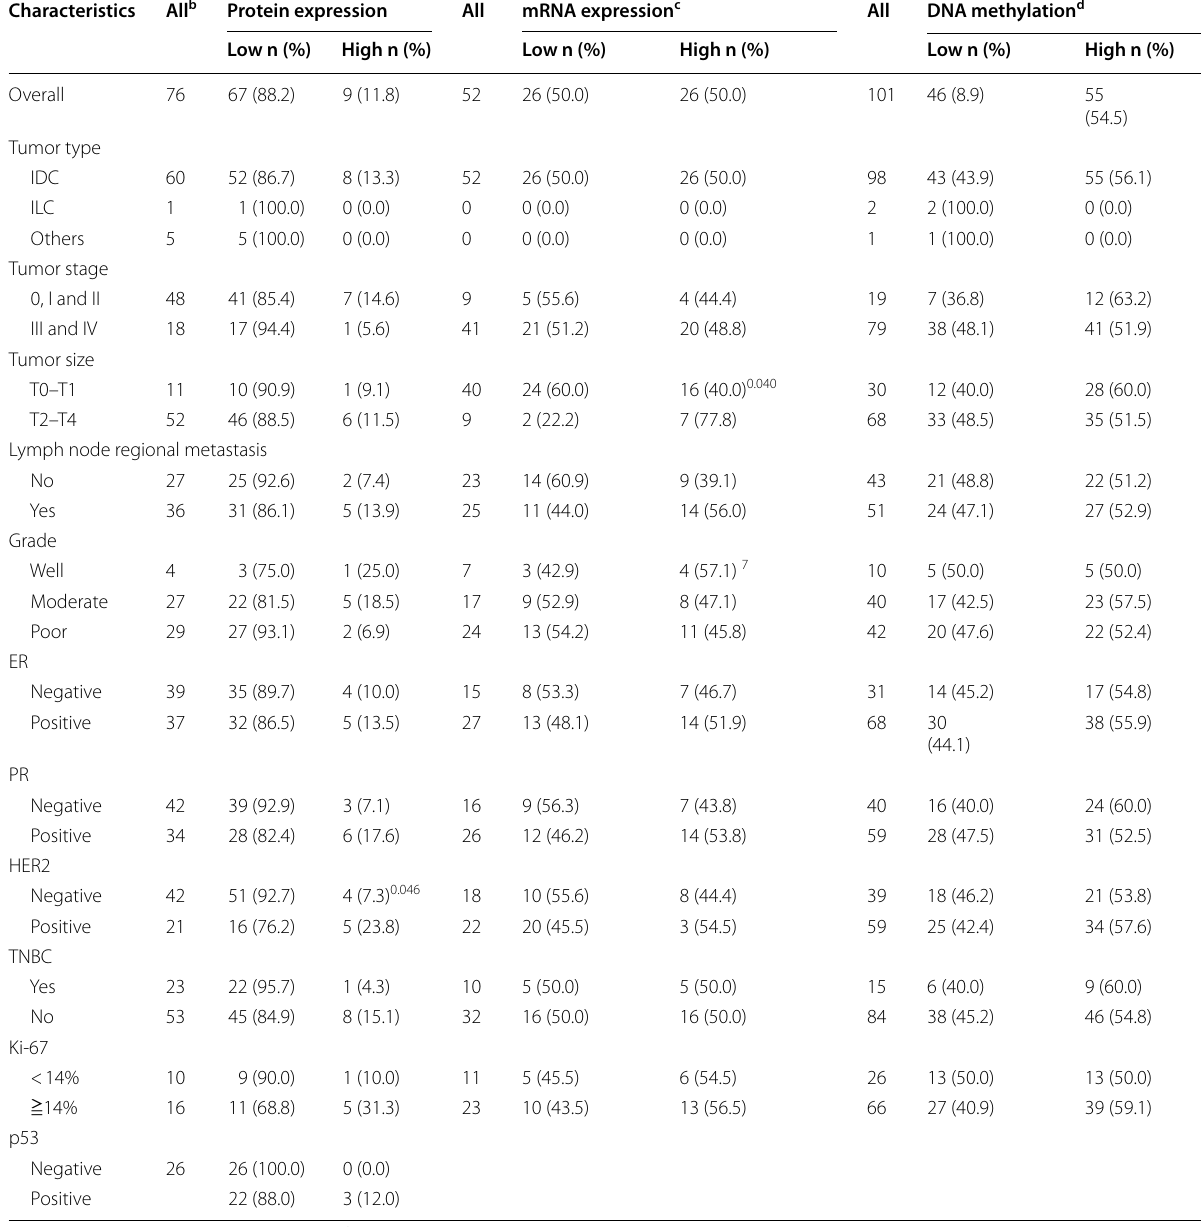
Table 1 TMEM240 protein, mRNA expression and promoter hypermethylation in relation to the clinical parameters of Taiwan breast cancer